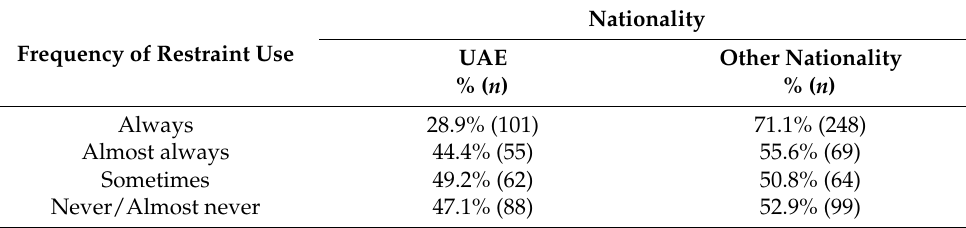
Table 5. Participants’ nationality and frequency of restraint use for their eldest child while travelling in a vehicle.